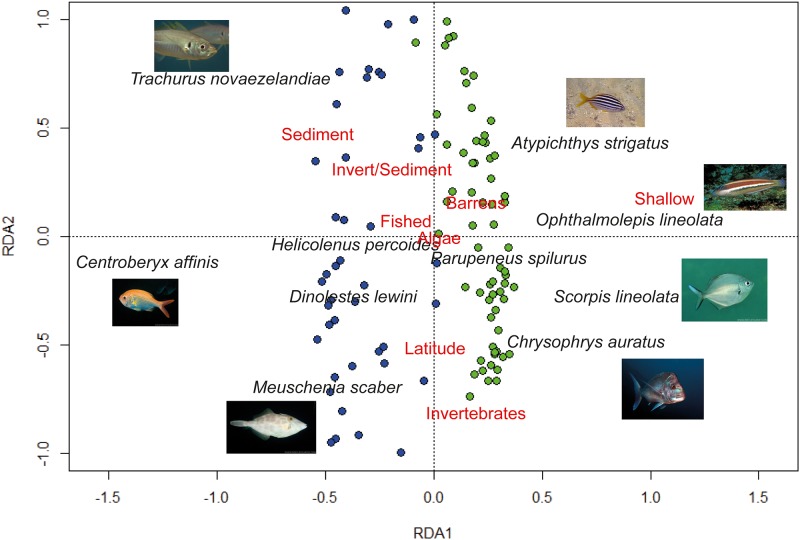
An RDA triplot ordination of transformed relative abundance data constrained by depth, latitude, fished/no-take.Filled circles represent mesophotic reef stereo-BRUV deployments and open circles represent shallow reef stereo-BRUV deployments.